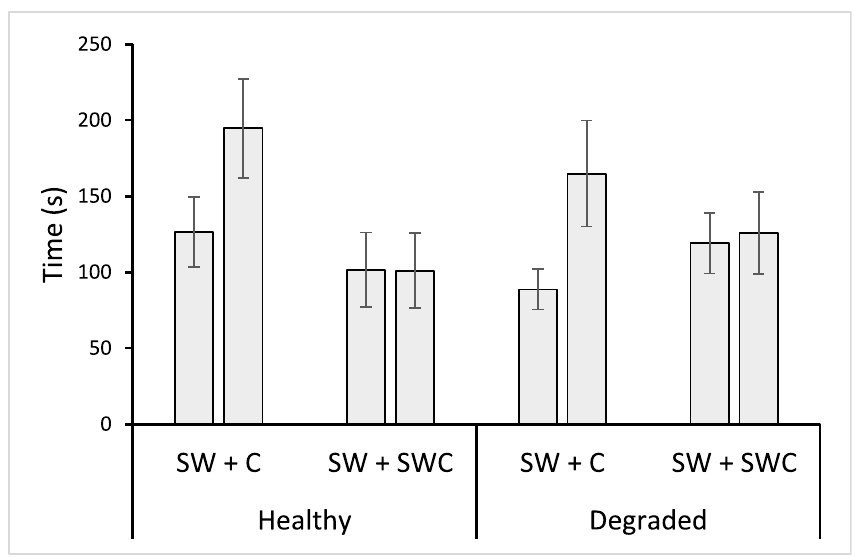
Fig 4. Predator response to prey damage odours or a seawatercontrol. Mean ( ± SE) time spent by Pseudochromis fuscus within chambers of y-mazes injectedwith seawater(SW) and either damage-released odoursfrom Pomacentrus amboinensis (C) or a seawatercontrol cue (SWC), againsta background of either healthyor degradedcoral treated seawater; n(left to right) 19, 19, 16, 16, 17, 17, 19, 19.